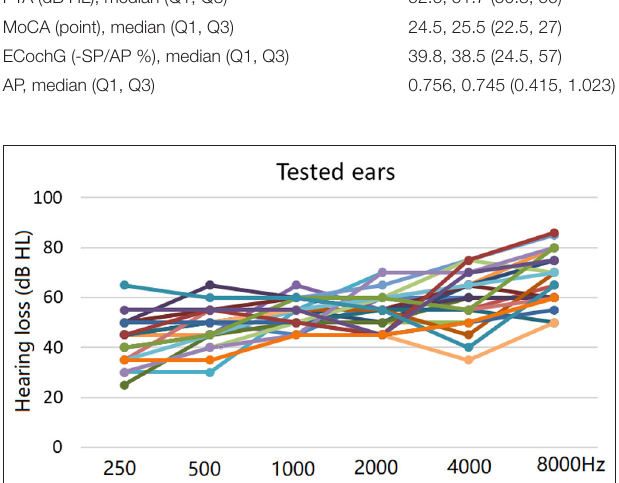
FIGURE 1 | Individual audiometric thresholds in test ears (13 left ears and 11 right ears) using pure tone